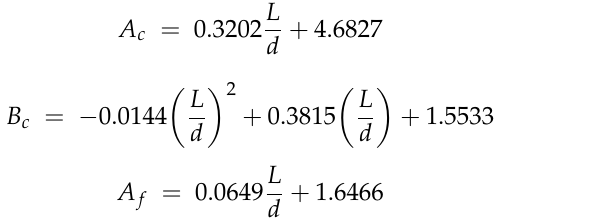
Figure 14. Effect of relative particle size: ( a ) ratio of simulated compressive strength to bond strength; ( b ) ratio of simulated flexural strength to bond strength; ( c ) ratio of simulated compressive strength to flexural strength.